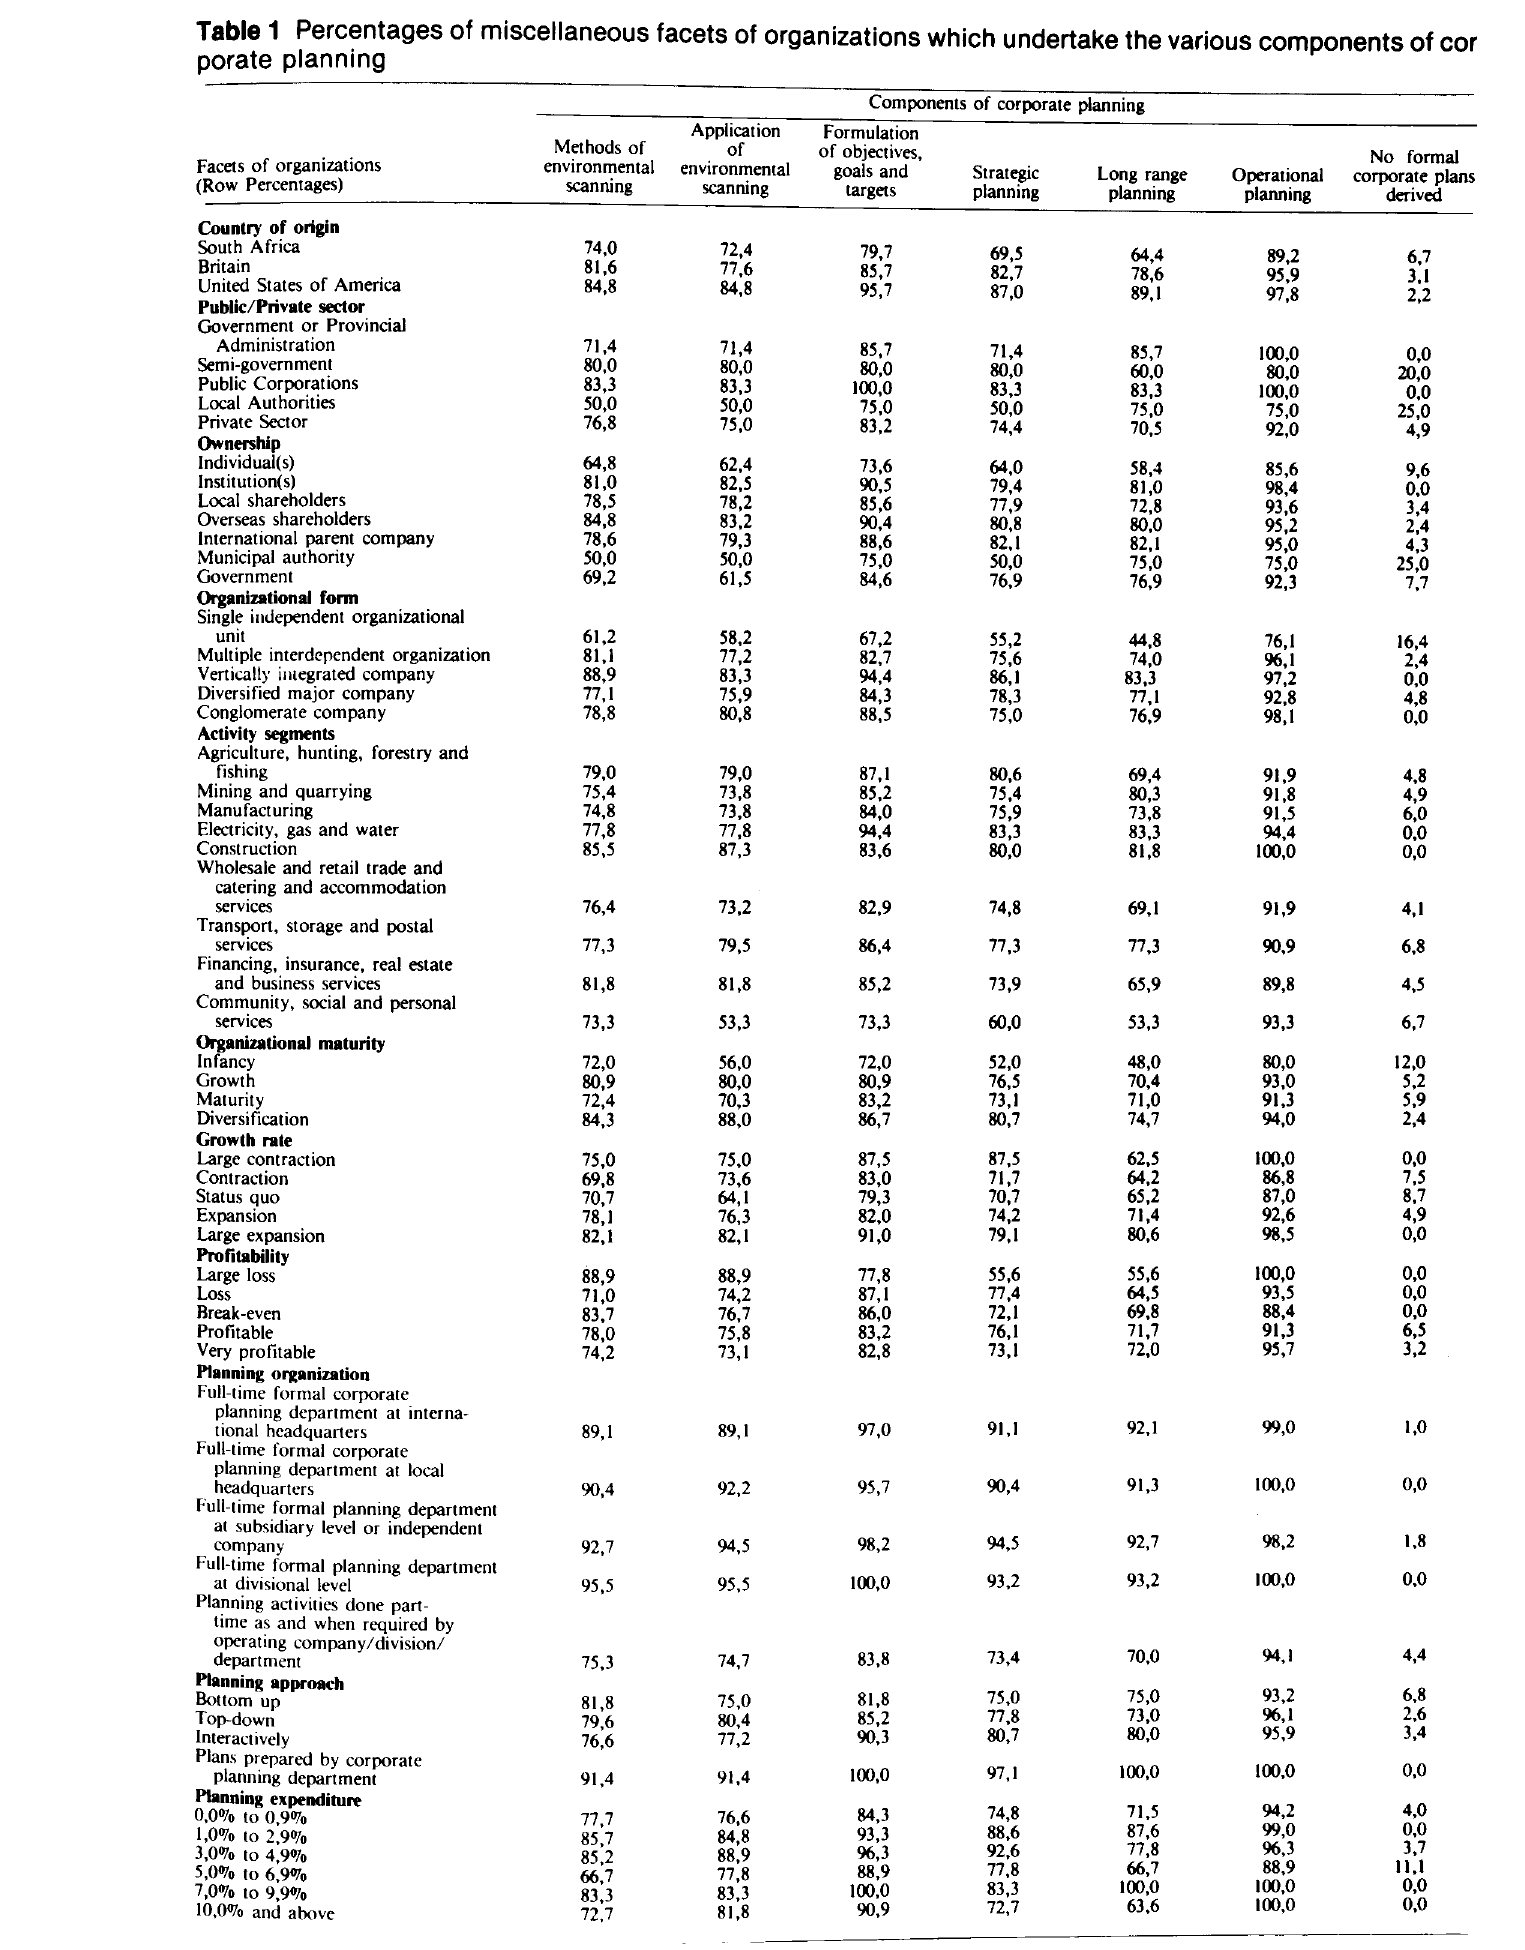
corporate plans (Row Percentages)